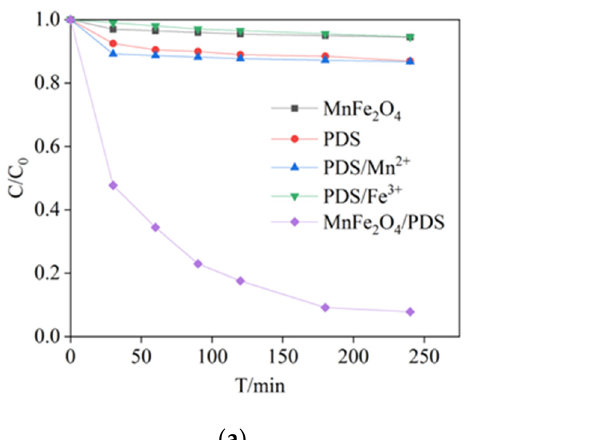
Figure 2. ( a ) Homogeneous and non-homogeneous conditions for degradation of PCA; ( b ) Degra- dation of PCA by different s olid catalysts. Experimental conditions: [PCA] = 20 mg/L, [MnFe 2 O 4 ] = [Fe 2 O 3 ] = [Mn 2 O 3 ] = [Fe 3 O 4 ] = 1.3 g/L, [Fe 3+ ] = [Mn 2+ ] = 5.6 mM, [PDS] = 2.4 mM and pH = 7.00 ± 0.02.